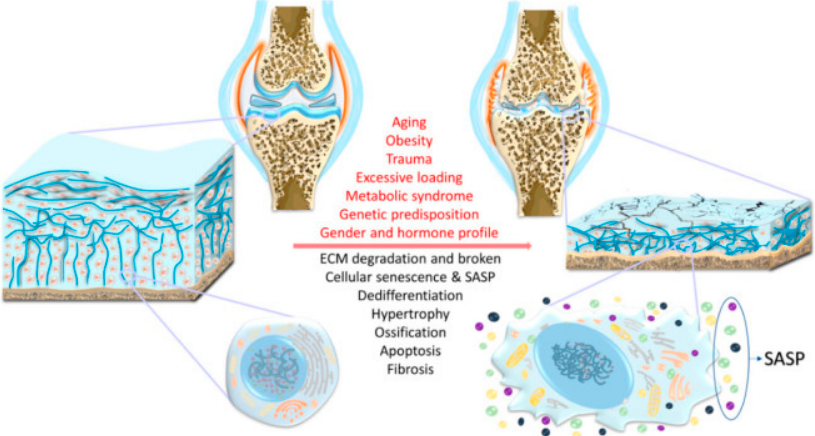
Figure 1. Risk factors (described in red) contributing to the development of osteoarthritis (OA). Description of structural alteration and chondrocyte-specific changes in osteoarthritis (described in black). ECM: Extracellular matrix; SASP: Senescence-associated secretory phenotype. Adapted from [12], MDPI, 2017.